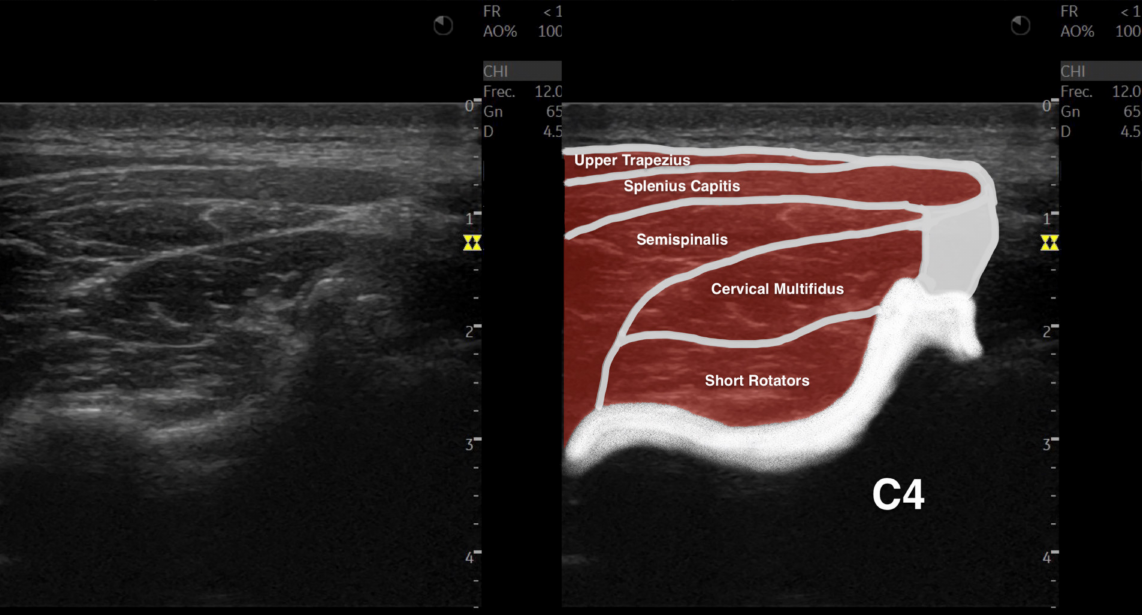
Figure 1. Ultrasound imaging acquisition and measurement: Example image illustrating the cervical multifidus muscle acquisition at the C4–C5 level (left), and with muscular structures labeled (right). The inter-examiner reliability analysis consisted of (1) central tendency and dispersion for each metric obtained by each examiner, (2) absolute error between examiners (absolute error was calculated because signs could underestimate the disagreement magnitude), (3) intraclass correlation coefficients (ICC 3,2 calculated with a 2-way mixed model, consis- √ tency type), (4) standard error of measurements (SEM= 1 − ICC × standard deviation of √ mean scores), and (5) minimum detectable changes (MDC 95 = SEM × 1.96 × 2)